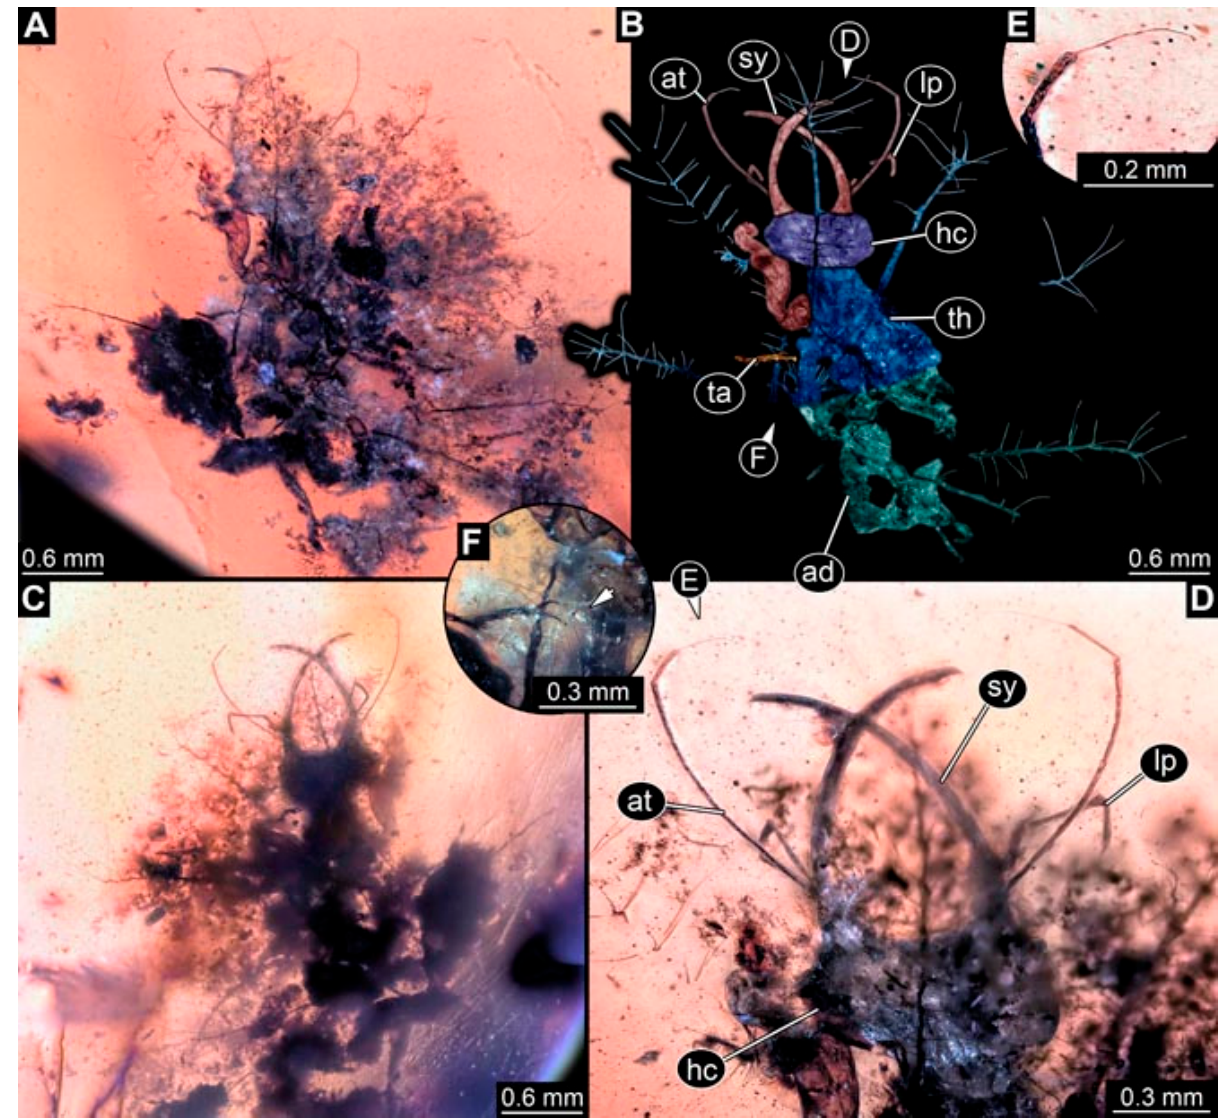
Figure 33. Specimen 4858 (PED 0901); Myanmar amber. ( A ) Dorsal view. ( B ) Dorsal view, colour- marked. ( C ) Ventral view. ( D ) Close-up of head capsule in dorsal view. ( E ) Close-up of antenna in dorsal view. ( F ) Close-up of trunk appendages with empodium (arrow). Abbreviations: ad = abdo- men; at = antenna; hc = head capsule; lp = labial palp; sy = stylet; ta = tarsus; th = thorax.